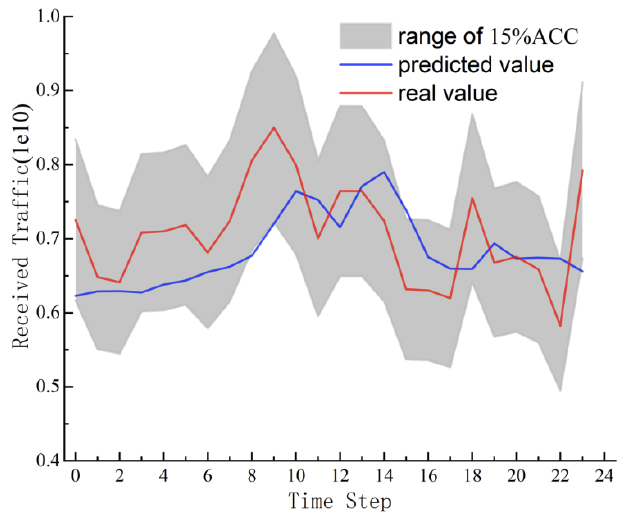
Figure 10. TCN model prediction results.